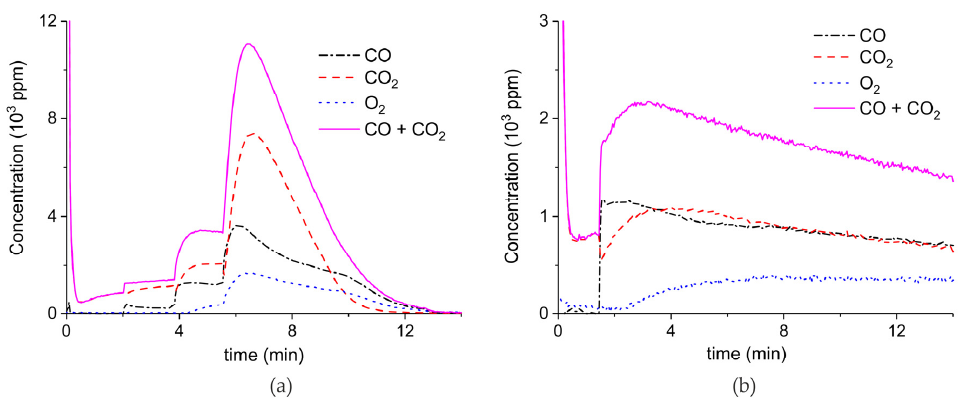
Figure A4. Concentration of the products of CaCO 3 decomposition (sample D) as function of time at 630 °C in pure argon and flow rate of 30 mL/min. Plasma power is 0.2, 2.3, and 8.1 W ( a ) and 1.3 W ( b ). Plasma is turned on after 2 min and changed every 2 min (a) or after 1.5 min (b).